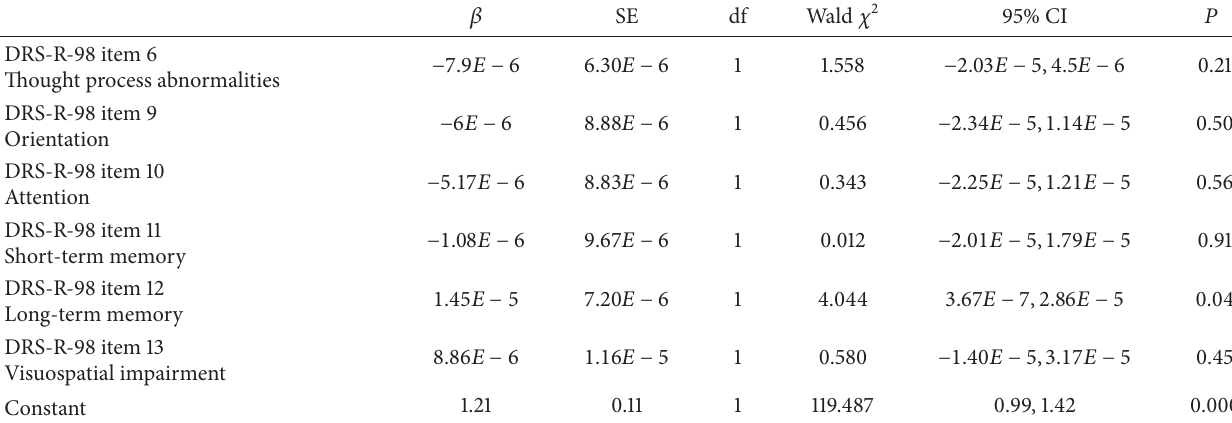
Table 3: Generalised equation estimation (GEE) model for DRS items 1–13 for different lengths of delirium episodes until recovery (count of days). 𝑁 = 113 included observations.